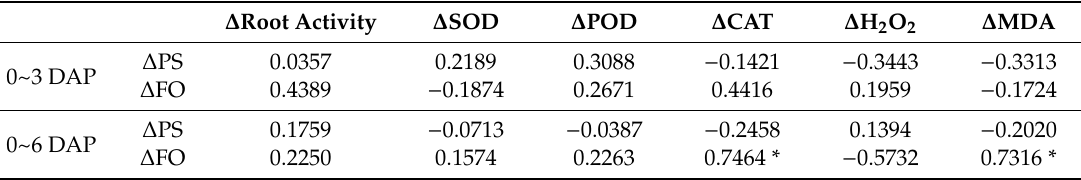
Table 5. Pearson correlations among the variation of the two microorganisms and the six physiological indexes under replant disease stresses during three and six days after transplanting. ∆ Root Activity ∆ SOD ∆ POD ∆ CAT ∆ H